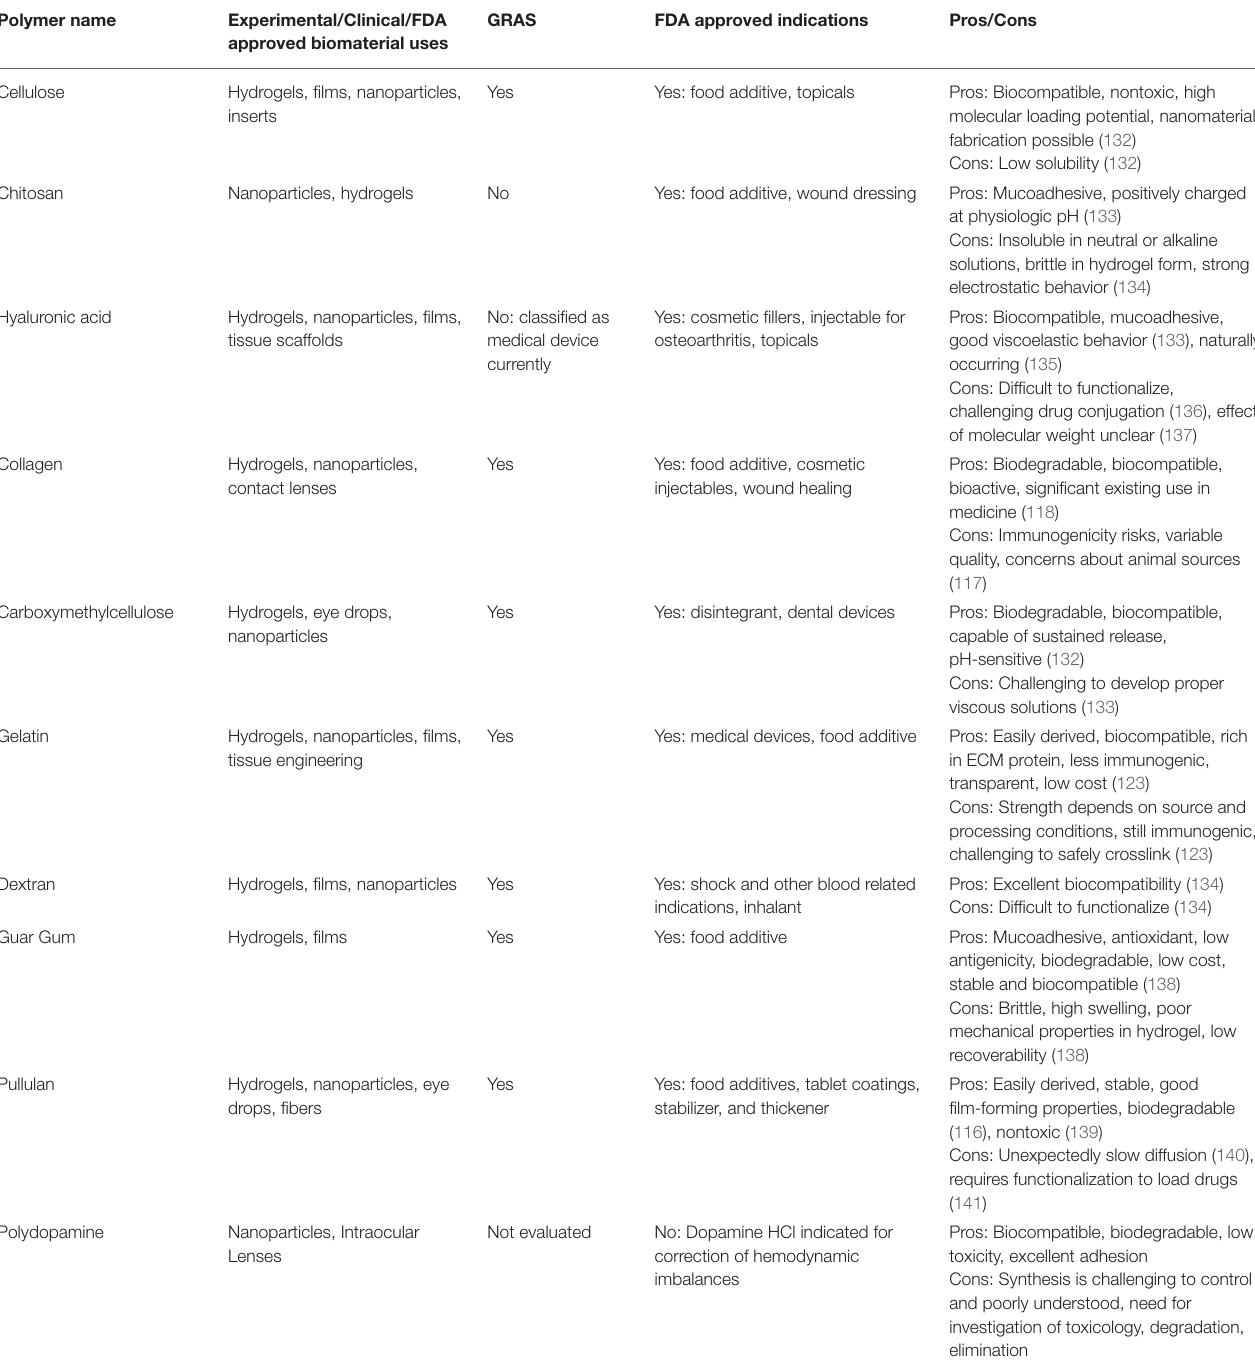
TABLE 2 | Summary of biopolymers used in ocular drug delivery and their properties. Polymer